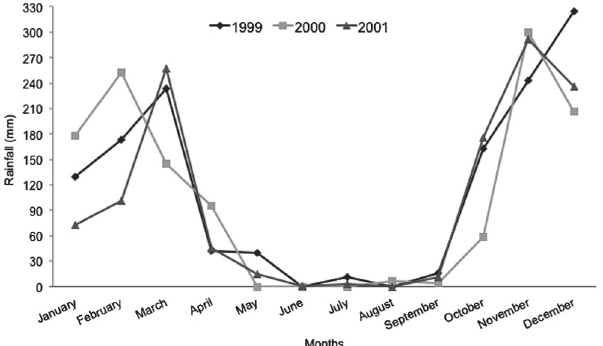
Fig. 3 . Monthly rainfall recorded in the years of 1999, 2000 and 2001. Source: INMET, Posse municipality, Goiás State, central Brazil.